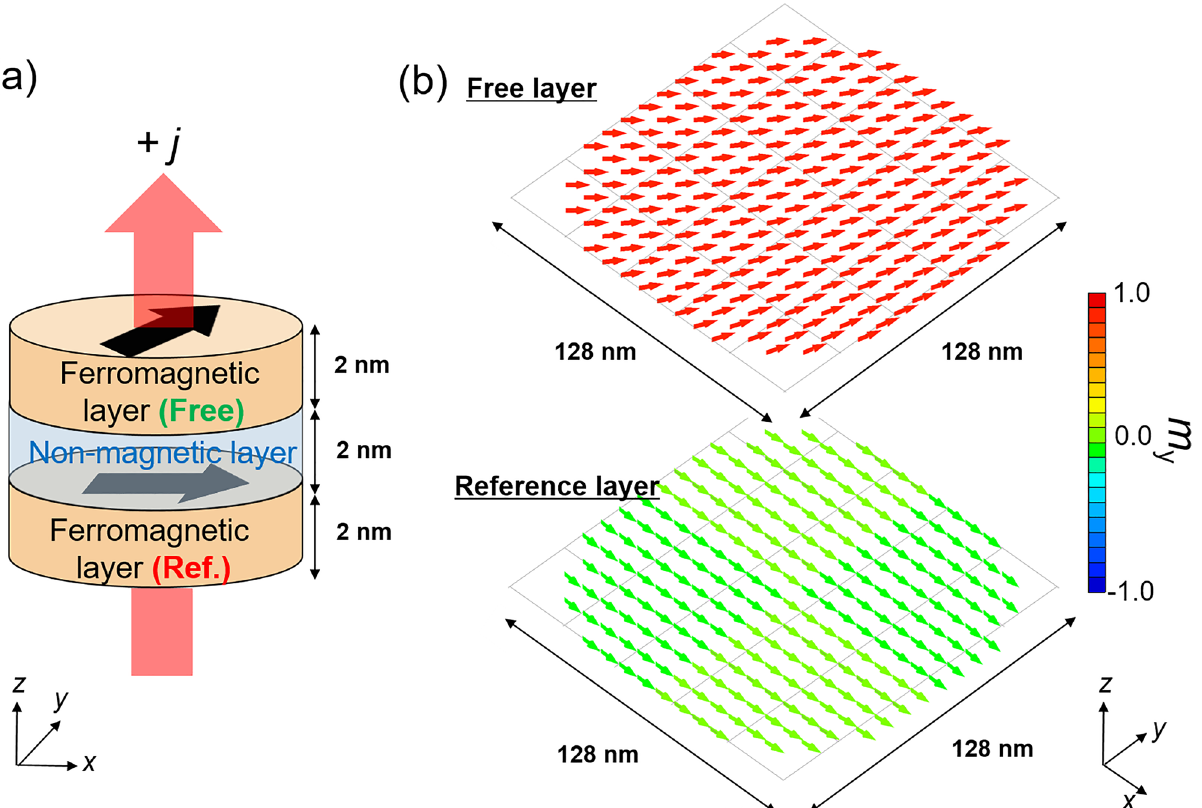
Figure 1. ( a ) Schematic illustration of FM/NM/FM trilayer. ( b ) Equilibrium magnetization state in trilayer magnet with ( J 1 , J 2 ) = ( 0.6, − 0.6 ) mJ/m 2 . The arrows indicate the magnetic moment directions and the colors indicate the y -direction magnetization components. The arrows were enlarged using average magnetic vector of 4 × 4 square